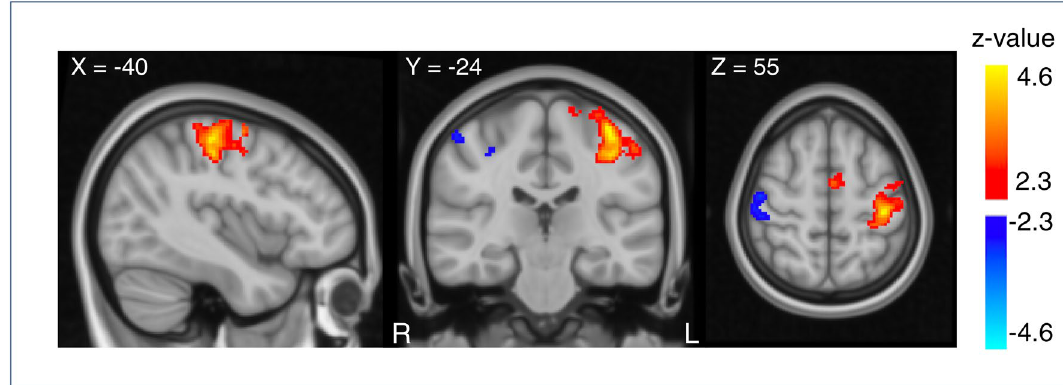
Figure 1. Perfusion changes during right hand finger-tapping before stimulation (FT-pre) on all subjects. Regions show changes in perfusion during FT compared to resting state. Subjects show increase in perfusion corresponding to the left sensorimotor cortex (red), (Cluster size = 1294, Z-max = 4.68, peak coordinate: − 38, − 24, 60, cluster p-value = 1.72e−08) and decreased perfusion corresponding to the right sensorimotor cortex (blue) (Cluster size = 244, Z-max = 3.0, peak coordinate: 50, − 14, 54, cluster p-value = 0.047). Results are overlaid on MNI template. The figure shows the results for a voxel-wise threshold at p = 0.01 (Z = 2.3) and cluster corrected threshold of p = 0.05 for illustrative purposes. Perfusion changes during tDCS did not survive the cluster-corrected level. The primary analysis was performed with a cluster-defining threshold of p = 0.001 (Z = 3.1) at the voxel level and cluster corrected threshold of p = 0.05 (shown in Supplementary Fig. 2).